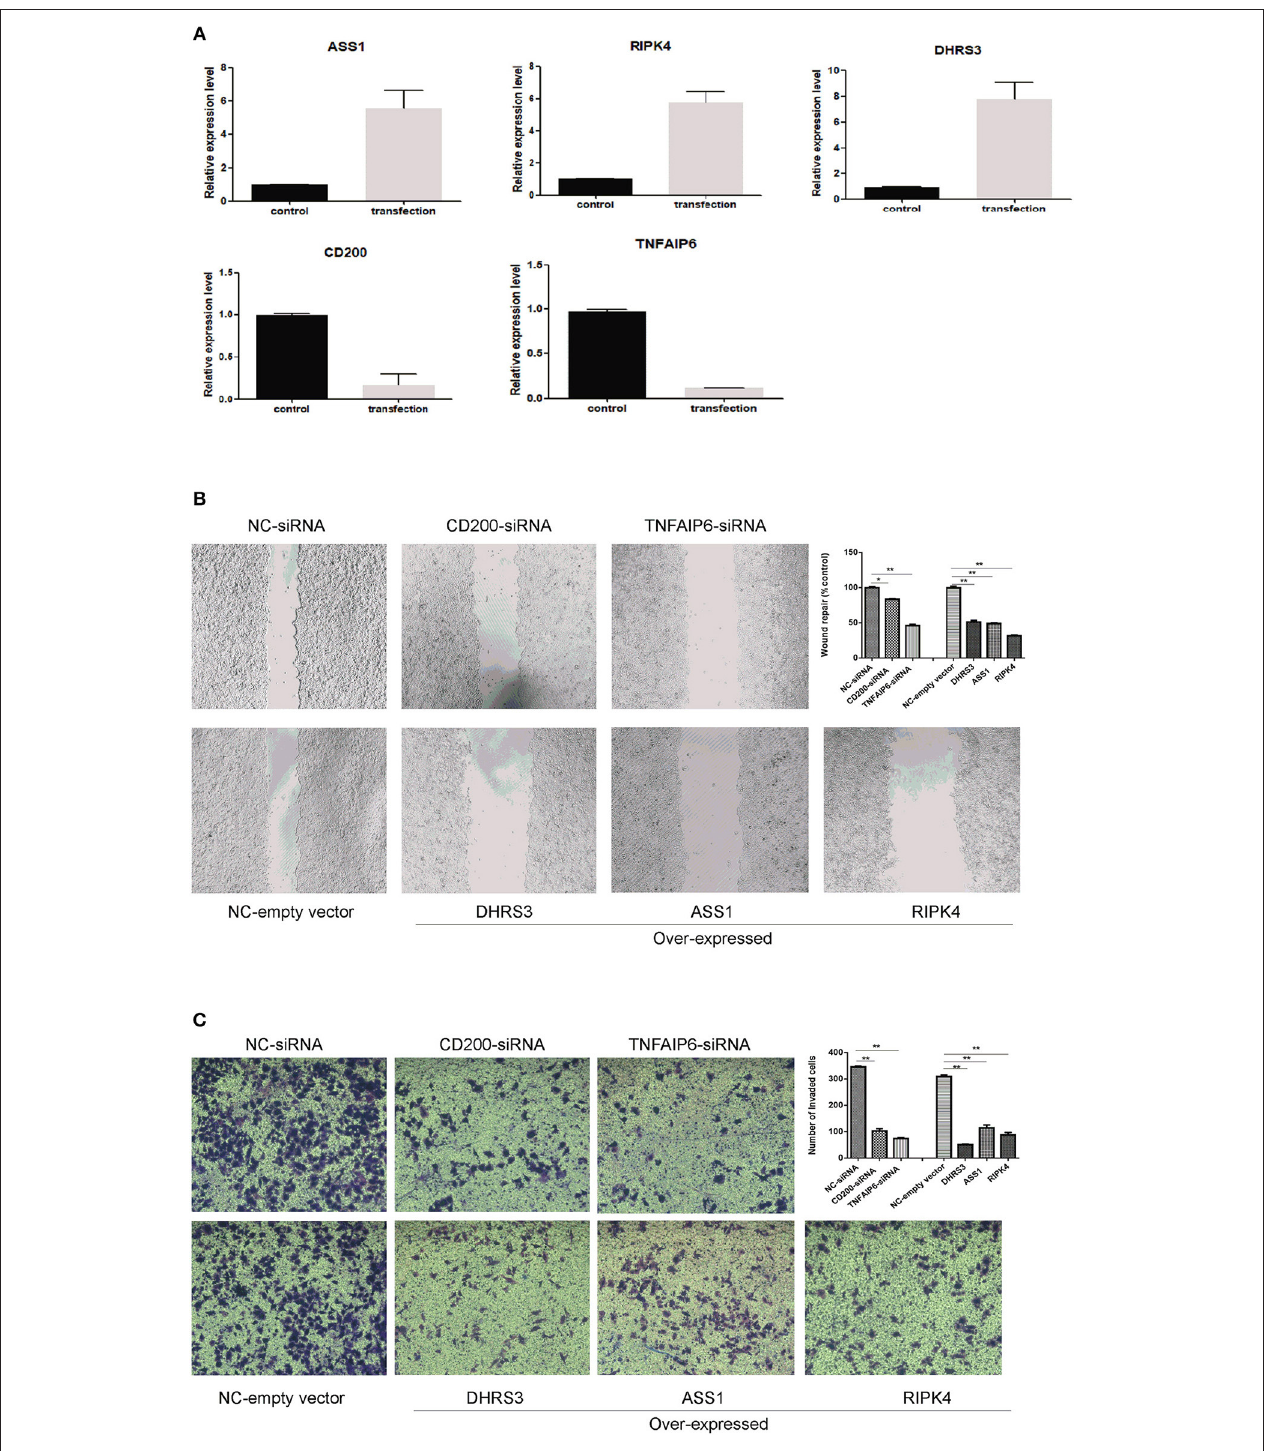
FIGURE 7 | Wound healing assay and transwell invasion assay. (A) RT-PCR analysis of selected gene expression in MCF-7 cells after knocking down and knocking-up treatment. (B) wound closure was shown at 48h post scratch (200 × ). Cell migration was assessed by recover of the scratch. The area of the wound was measured at the two time points in every group, and % reduction of initial scratch area was compared with control; and the results were expressed as percentage relative to the corresponding blank control. (C) Transwell invasion assay. MCF-7 cells penetrating the membrane were fixed and 0.1% crystal violet stained after 24h as described in experimental procedures, and cell number penetrating the membrane were counted for each group. * P < 0.05, ** P < 0.01. Data were the means of three measurements and the bars represented SD of the mean.